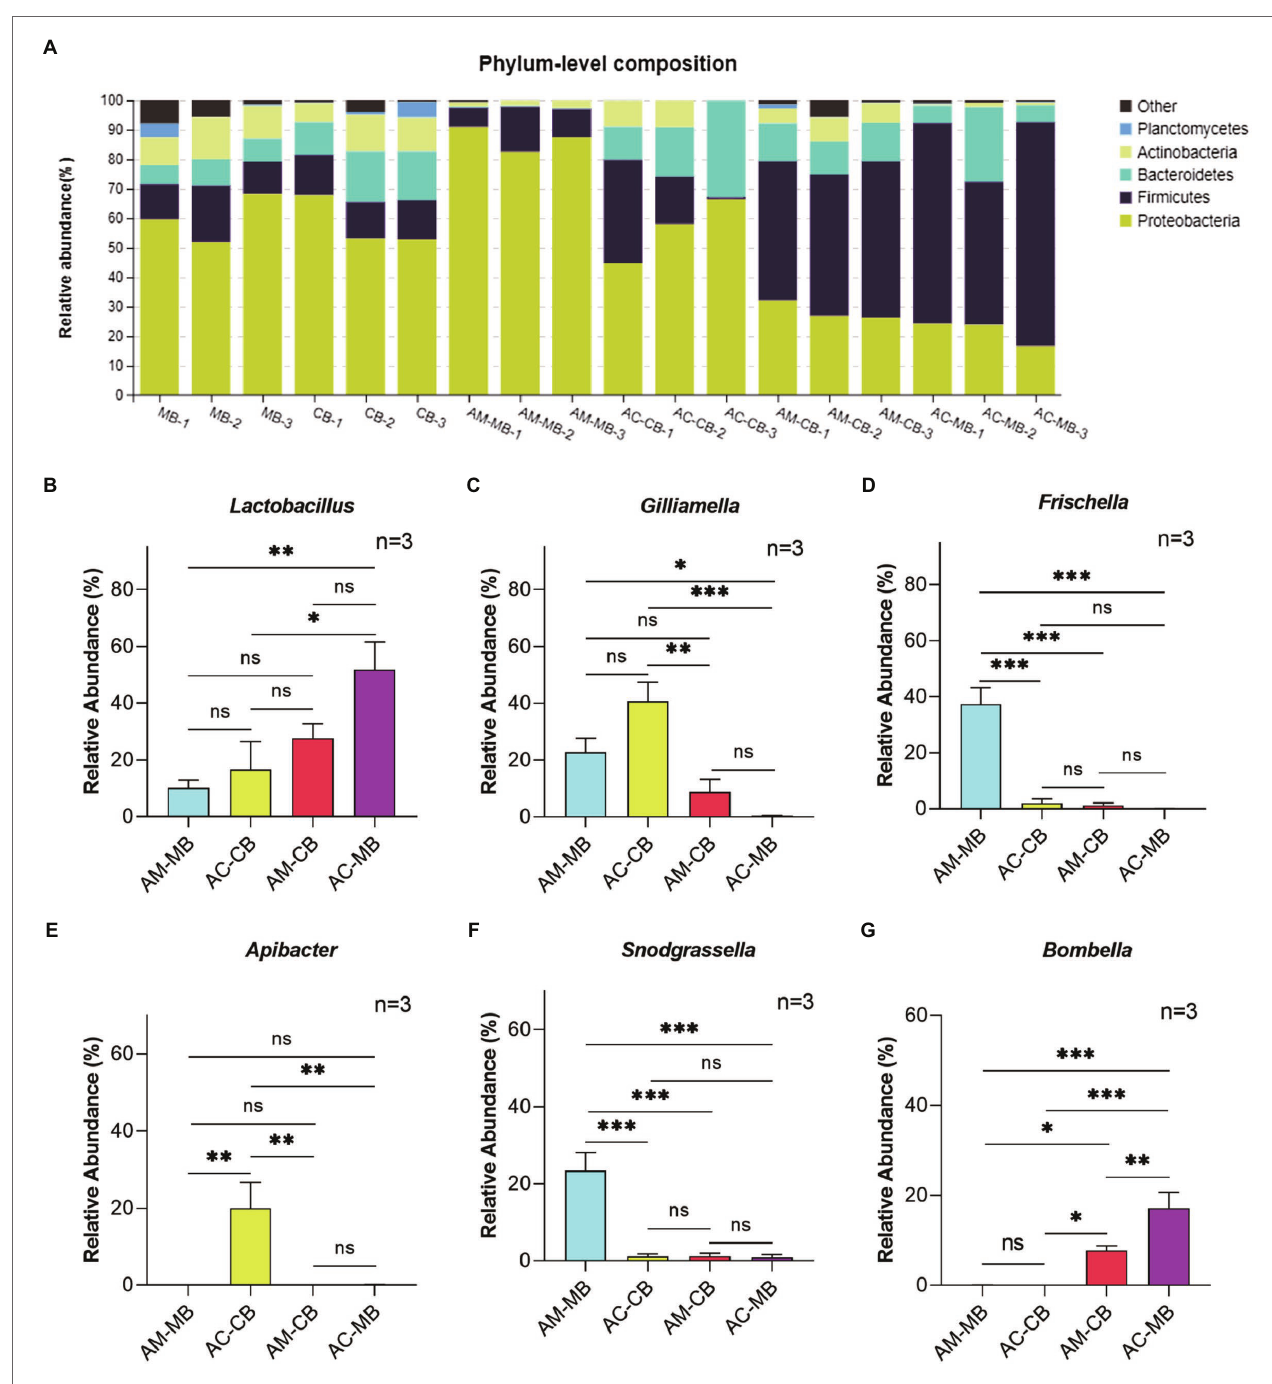
FIGURE 2 | Comparison of major phyla and genera. (A) The relative abundances of the five most abundant bacterial phyla in all samples. (B–G) Comparison of the relative abundances of the genera Lactobacillus (B) , Gilliamella (C) , Frischella (D) , Apibacter (E) , Snodgrassella (F) , and Bombella (G) in the studied